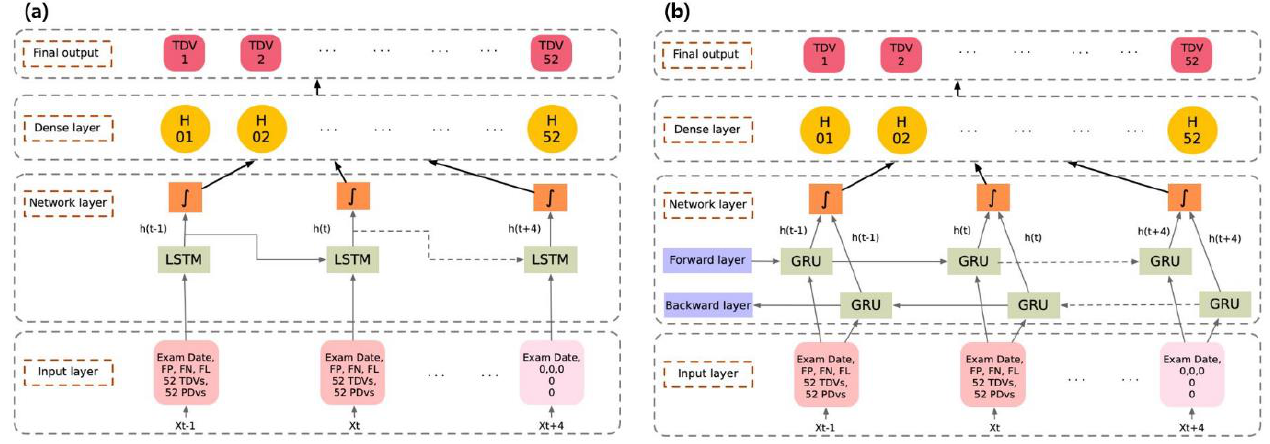
Figure 3. The architecture of the HMM and R-CNN models. HMM = Hidden Markov; R-CNN = recurrent CNN; DV = Deviation value. ( a ) The structure of the HMM method ( b ) The structure of the proposed R-CNN model.